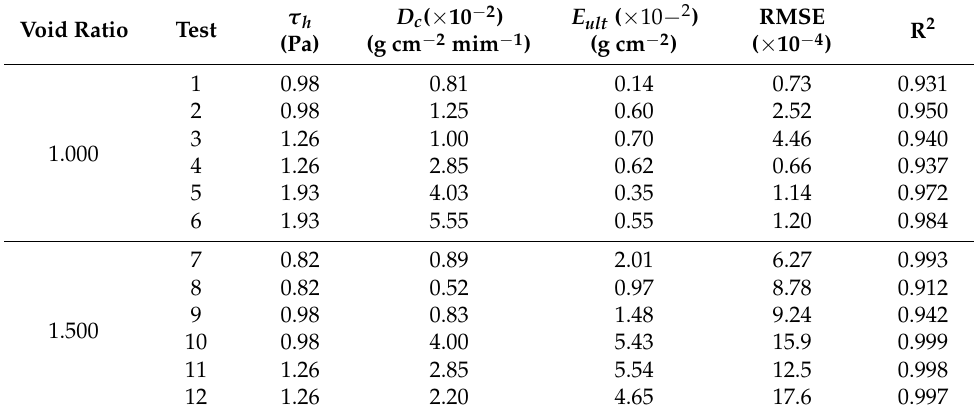
Table 1. Results of nonlinear regression modelling using the hyperbolic